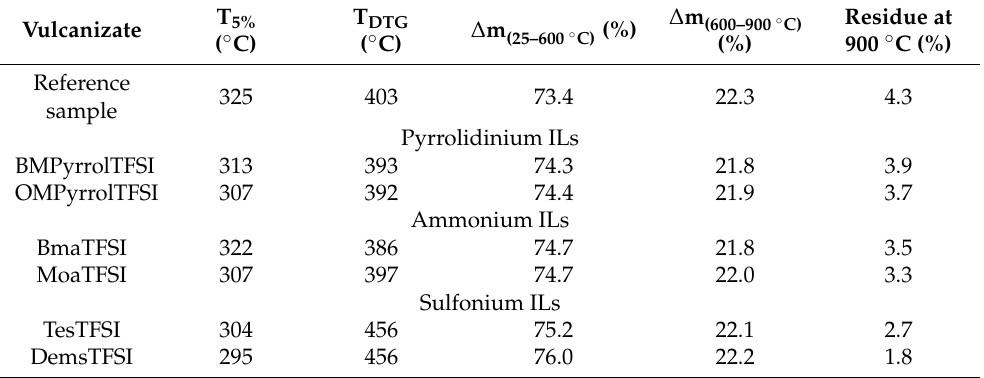
Table 9. Onset temperature of thermal decomposition (T 5% ), DTG peak temperature (T DTG ), and